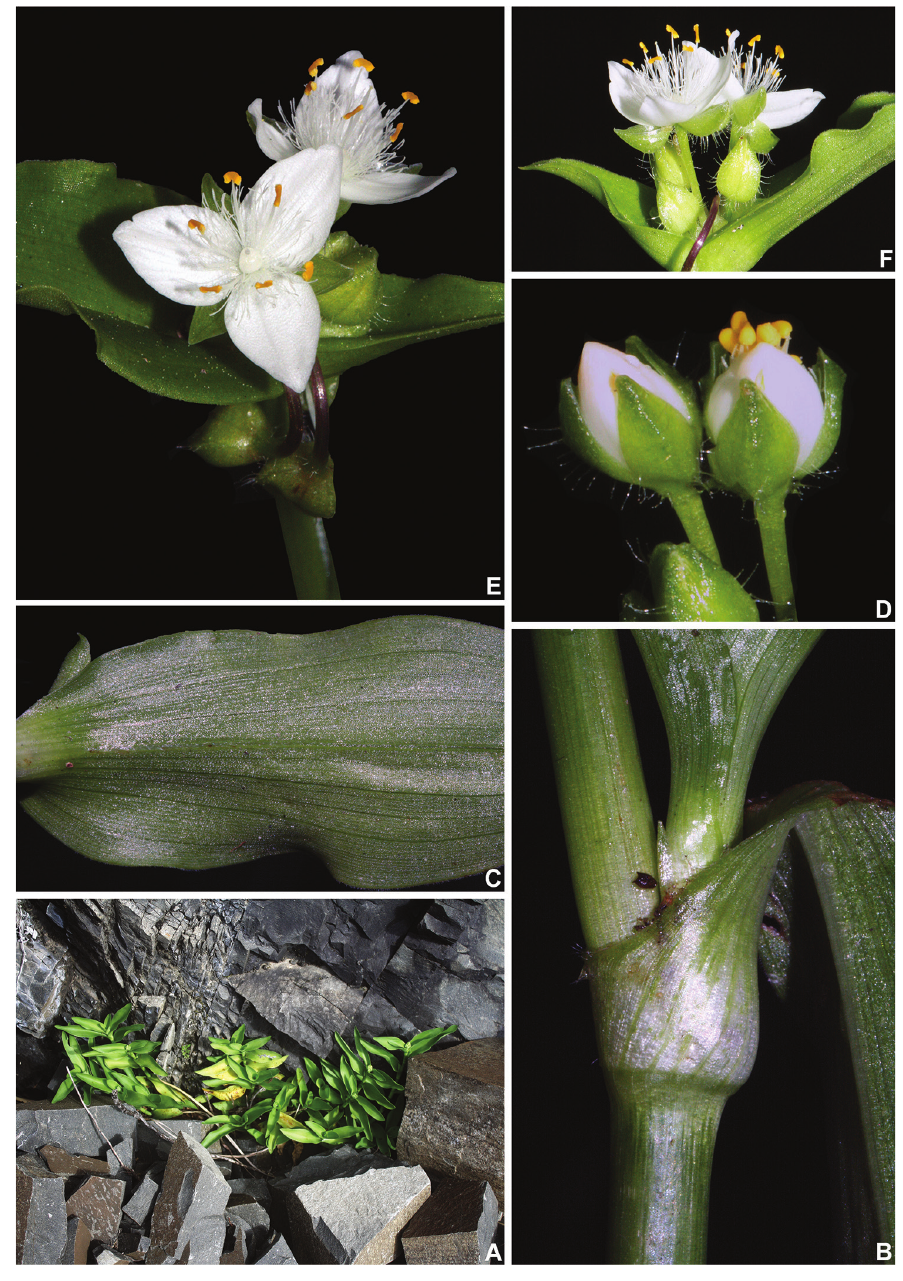
Figure 1. Tradescantia crassula Link & Otto. A habit, showing the erect stems, and distichously-alter- nate leaves with conduplicate blades B detail of the stem and leaf-sheath C detail of the abaxial side of the leaf-blade, showing the lack of hairs and the slightly conspicuous secondary veins D detail of floral buds, showing the setose hairs, restricted to the keels of the sepals E flower F detail of the inflorescence, showing the non-saccate cincinni bracts. Photographs by M.O.O.